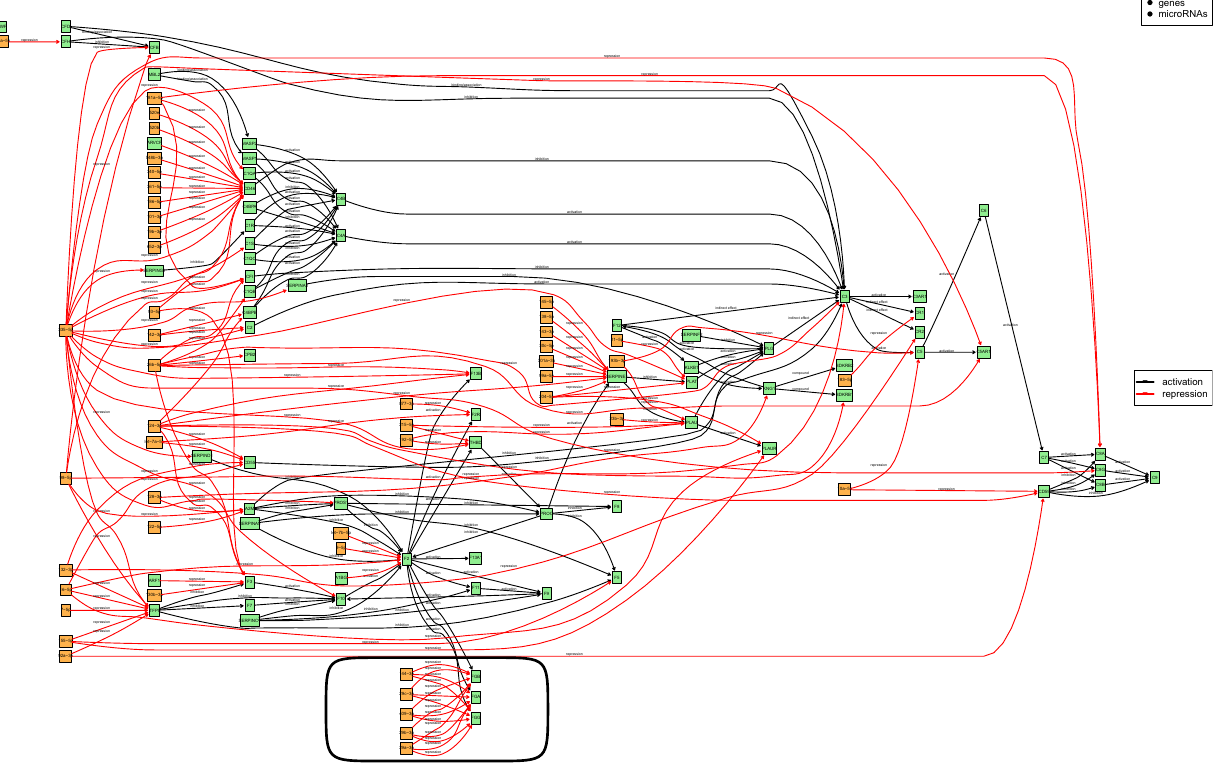
Figure 4. MiRIntegrator analysis for hsa-miR-144-3p. Graphical representation of the miRNA-augmented KEGG pathway hsa04610 “Complement and coagulation cascades” obtained using MiRIntegrator 67 (R package version 1.22, http:// datad. github. io/ mirIn tegra tor/, and R software version 3.5.1). The repression activity of hsa- miR-144-3p to its targets FGG , FGA and FGB genes is highlighted with a black